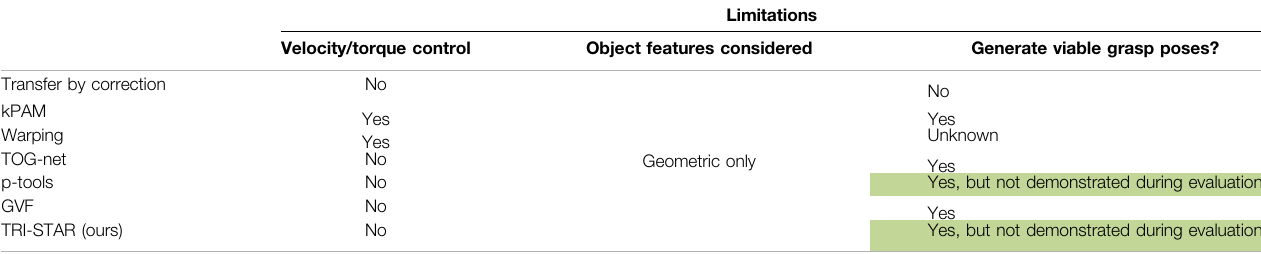
TABLE 3 | Comparison of major limitations. The table shows that while all frameworks considered only geometric properties of objects, some frameworks employed more sophisticated control techniques than TRI-STAR.